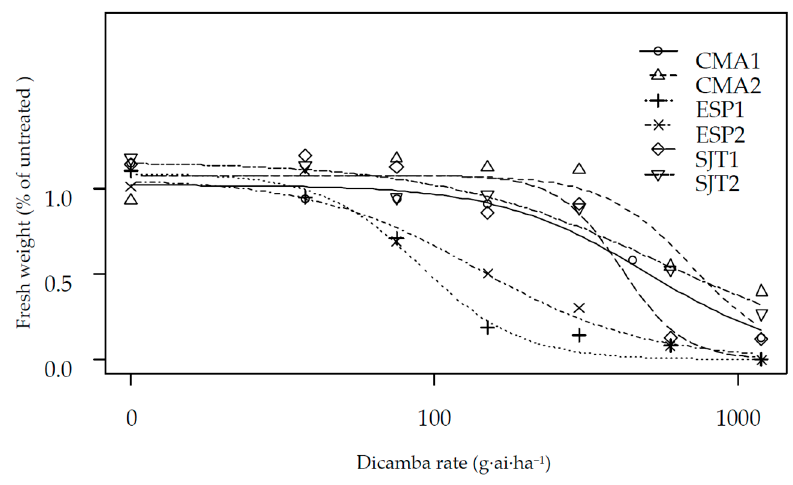
Figure 1. Weight response of six biotypes of Amaranthus hybridus to 2,4 ‐ D.